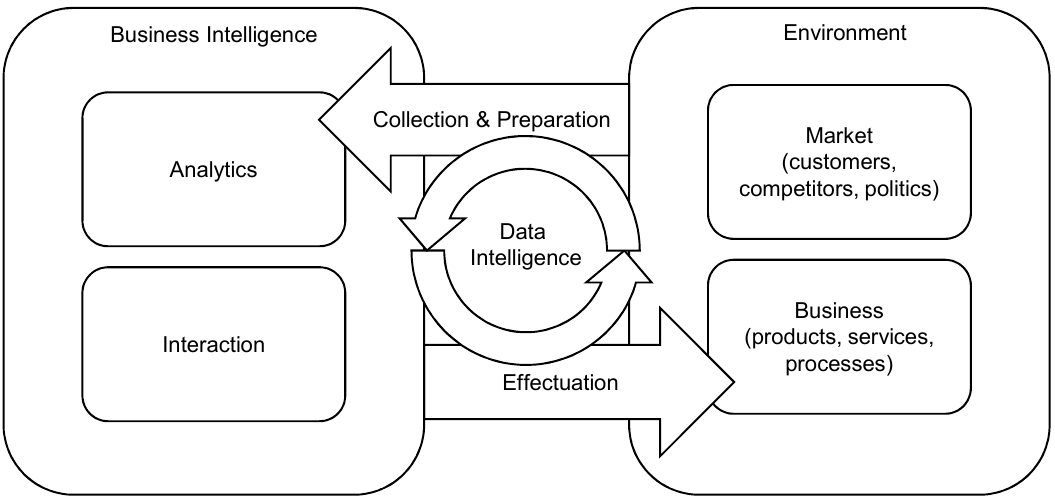
Figure 3. Application of the operational theory of emergent knowledge to business intelligence as a cognitive